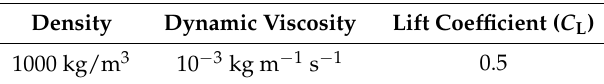
Table 2. Constant used for